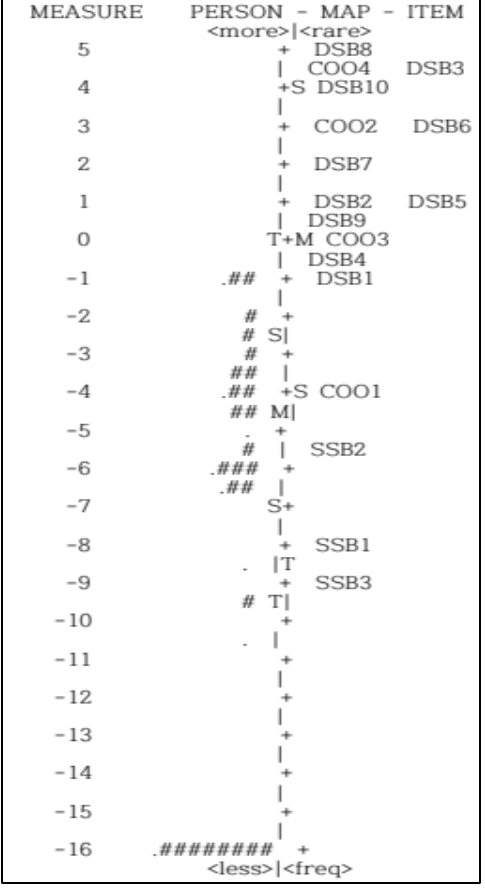
Figure 2. Map of personal proficiencies and item difficulties for the 17 items of the Trunk Impairment Scale. Note. More difficult items are placed on the top of the diagram. M, mean of child or item distribution; S, 1 standard deviation from the mean; T, 2 standard deviations. Each ‘#’ is two persons and each ‘ · ’ is one person. Table 4. Summary of the rating scale analysis of the